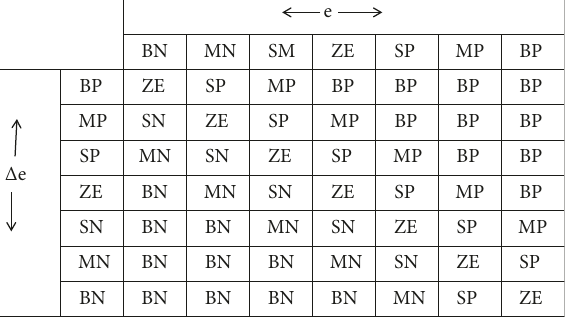
Figure 15: Membership function of